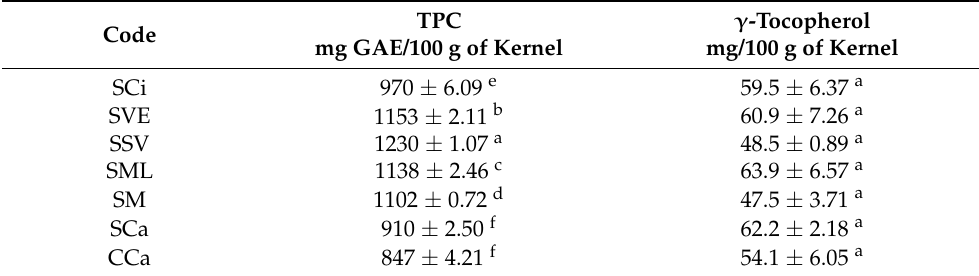
Table 6. Total phenol content (TPC) and γ -tocopherol content of kernels ( n = 3).